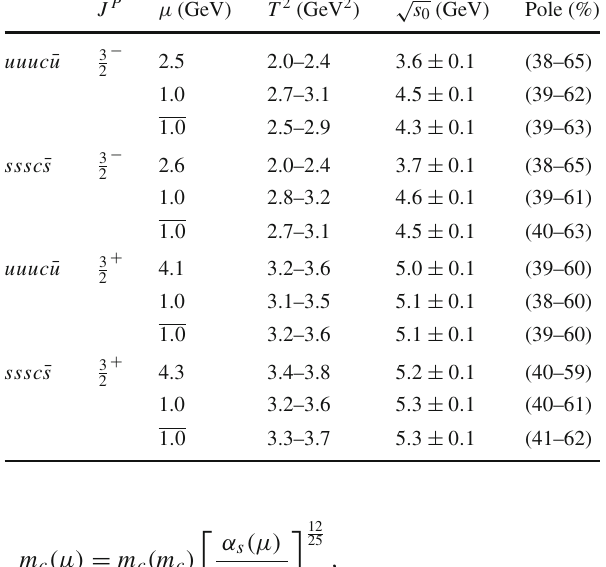
Table 1 The optimal energy scales μ , Borel parameters T 2 , continuum threshold parameters s 0 and pole contributions (pole) for the charmed pentaquark states J P